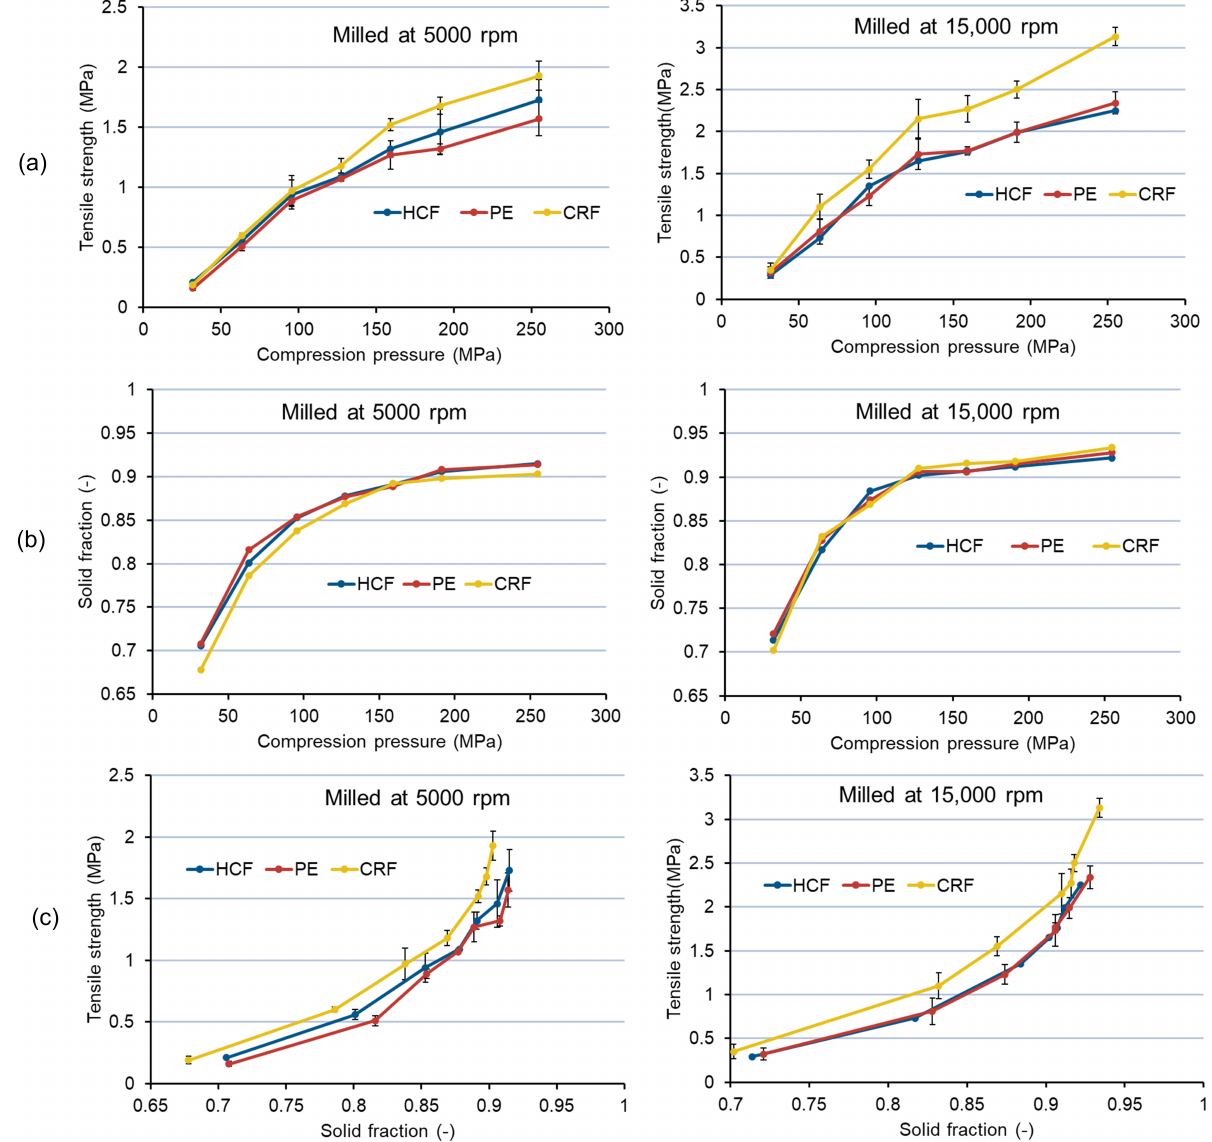
Figure 8. Compaction behavior of milled ASD extrudates: ( a ) tabletability profile, ( b ) compress- ibility profile, ( c ) compactibility profile. PSD of milled extrudates at both milling speeds (5000 and 15,000 rpm) is summarized in Table